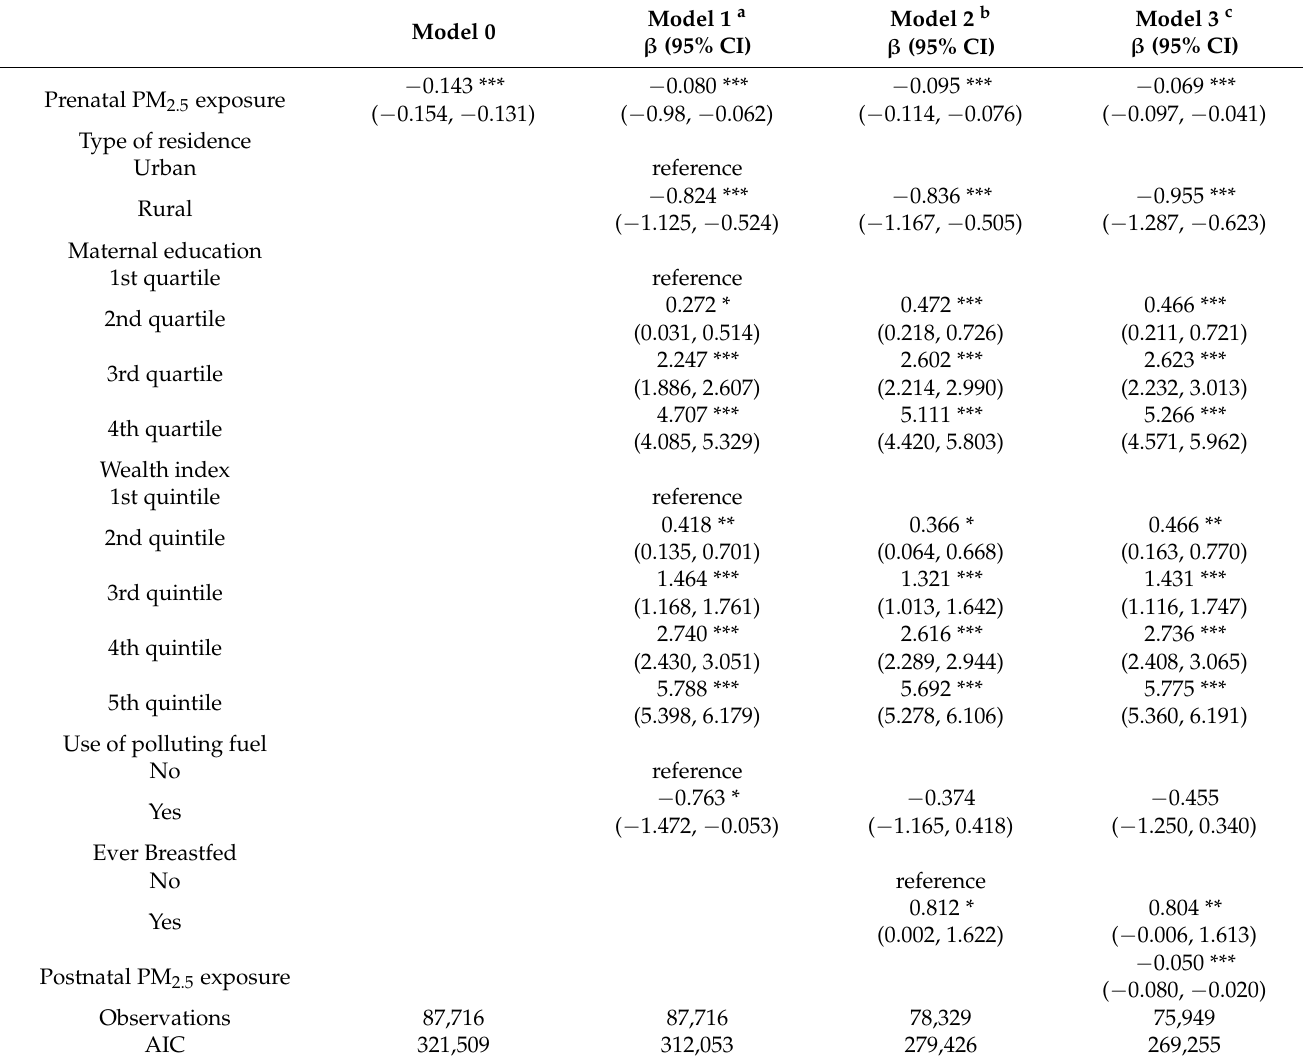
Table 4. Generalized additive modeling results showing crude and adjusted effect estimates for a 10 µ g/m 3 increase of prenatal PM 2.5 exposure and height-for-age in children under 5 years old. Model 1 a Model 3 c Model 2 b Model 0 β (95% CI) β (95% β (95% CI)